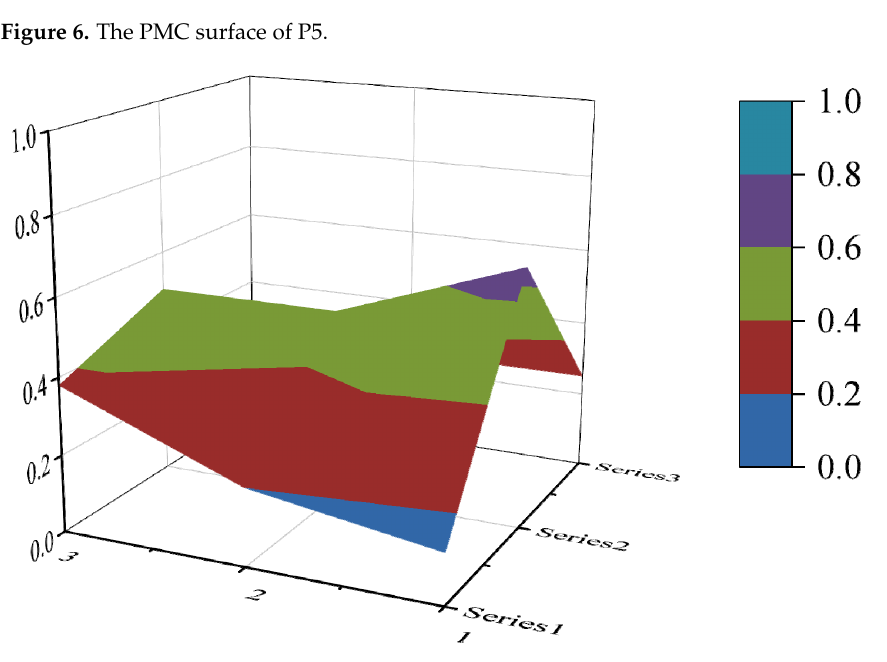
Figure 7. The PMC surface of P6.